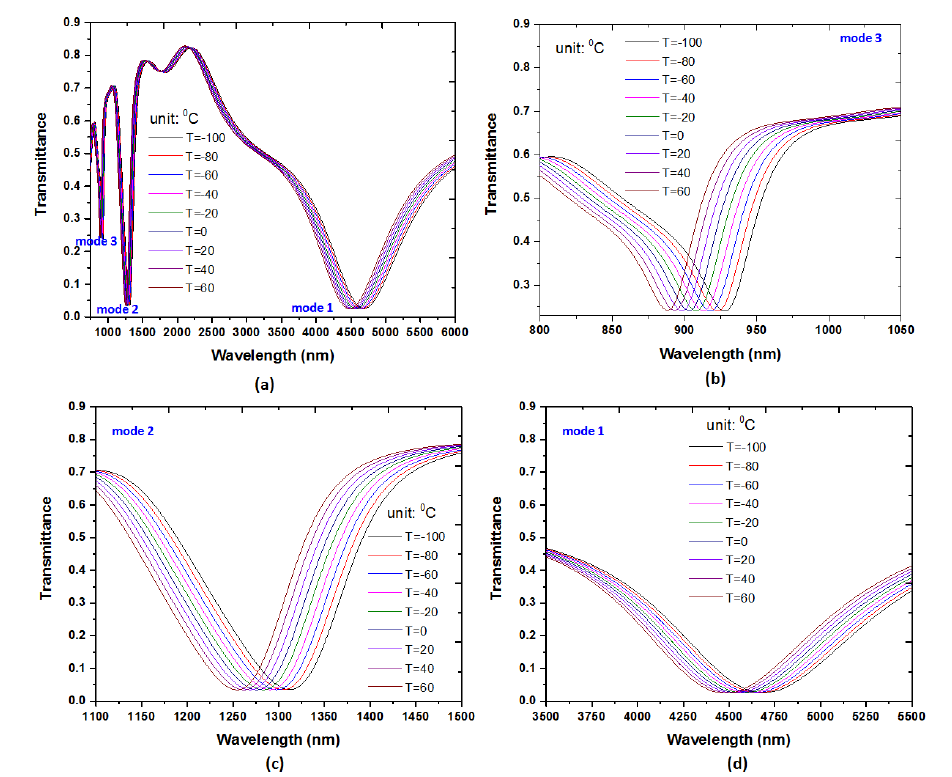
Figure 5. ( a ) Transmittance spectrum of the proposed MIM plasmonic waveguide with different ambient temperature in the wavelength range of 700–6000 nm. Transmittance spectrum of the proposed MIM plasmonic waveguide with different ambient temperature ( b ) in the wavelength range of 888–928 nm for mode 3, ( c ) in the wavelength range of 1254–1312 nm for mode 2, and ( d ) in the wavelength range of 4478–4688 nm for mode 1, respectively. The other parameters are set as the same as used in Figure 2.